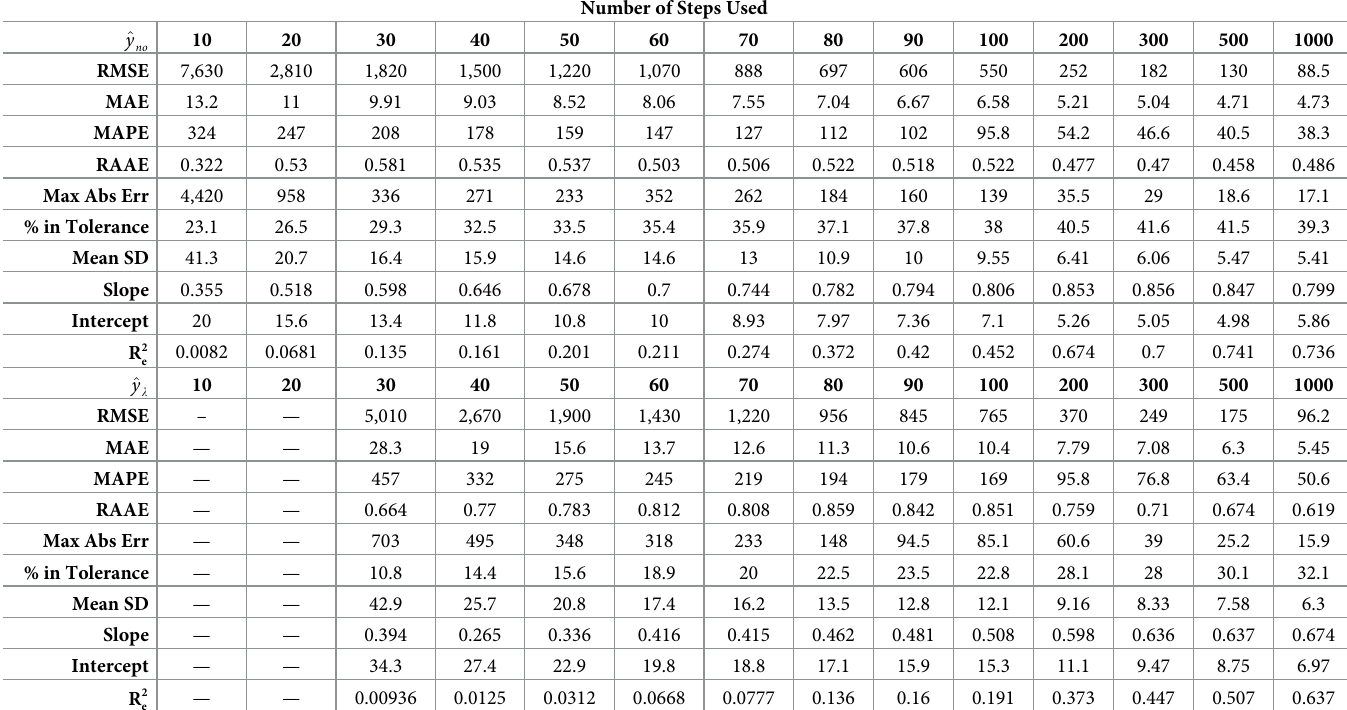
Table 7. Summary statistics for both combined fall risk models as the number of steps used changes. ^ y indicates the model that excludes the long-term Lyapunov no exponents, and ^ y indicates the model that includes this data. Each column indicates the number of steps used in the fall risk model. For each number of steps n , a simula- l tion was created (usually taken from a longer simulation), fall risk metrics were calculated from this simulation, the PCA transformation was applied, and then ln(MFPT) was estimated using Eq 12. The values are over all of the trials of a given number of steps n . The root mean squared error (RMSE), mean absolute error (MAE), mean abso- lute percentage error (MAPE), relative average absolute error (RAAE), and maximum absolute error (Max Abs Err) are given. The % in Tolerance indicates the percentage of these trials in which the predicted value was within the true ln(MFPT) ± 3.3. The mean SD are the mean of the standard deviation data for each training condition. The slope, intercept, and R